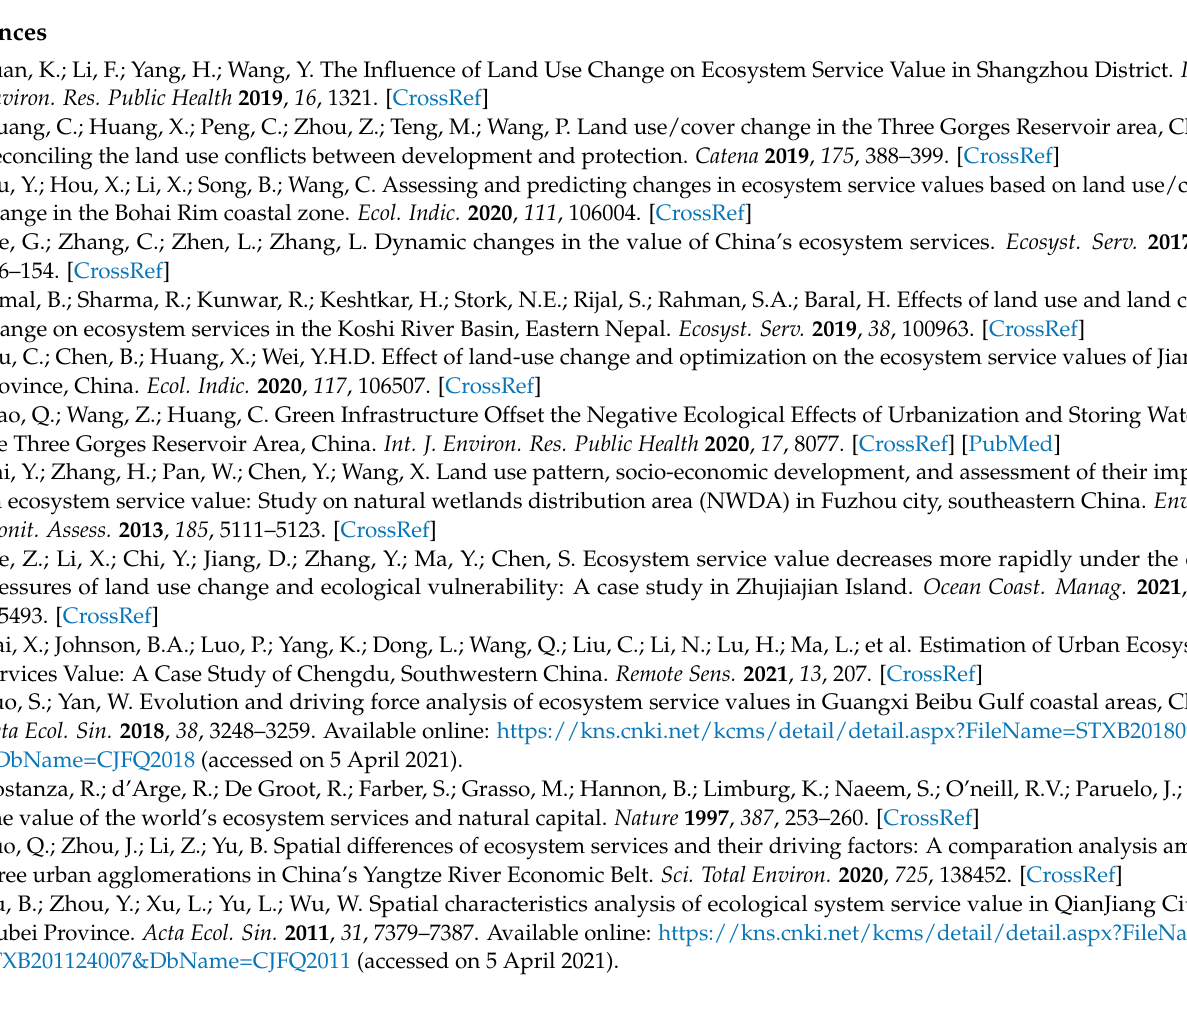
Table S2: Factors and weights for three land use scenarios. Table S3: ID and protection level in the constraints